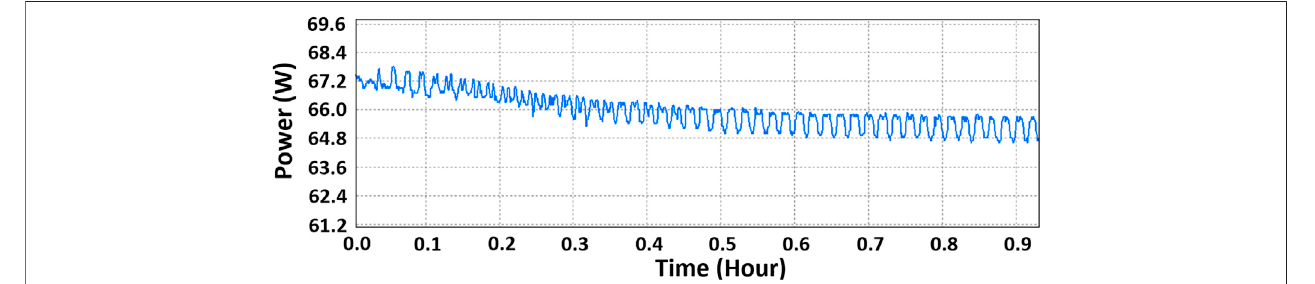
FIGURE 4 | Output power stability evolution of the 1,018 nm fi ber laser after the free-space